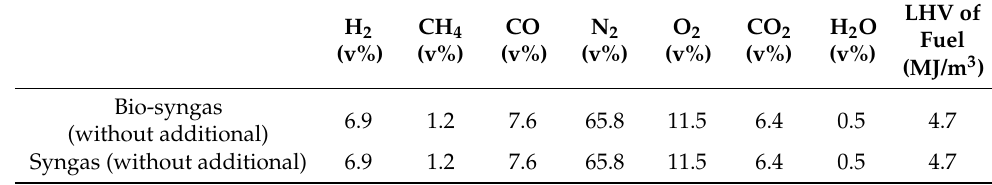
Table 1. Representative bio-syngas with air components in the cylinder. The air excess ratio is 1.3.